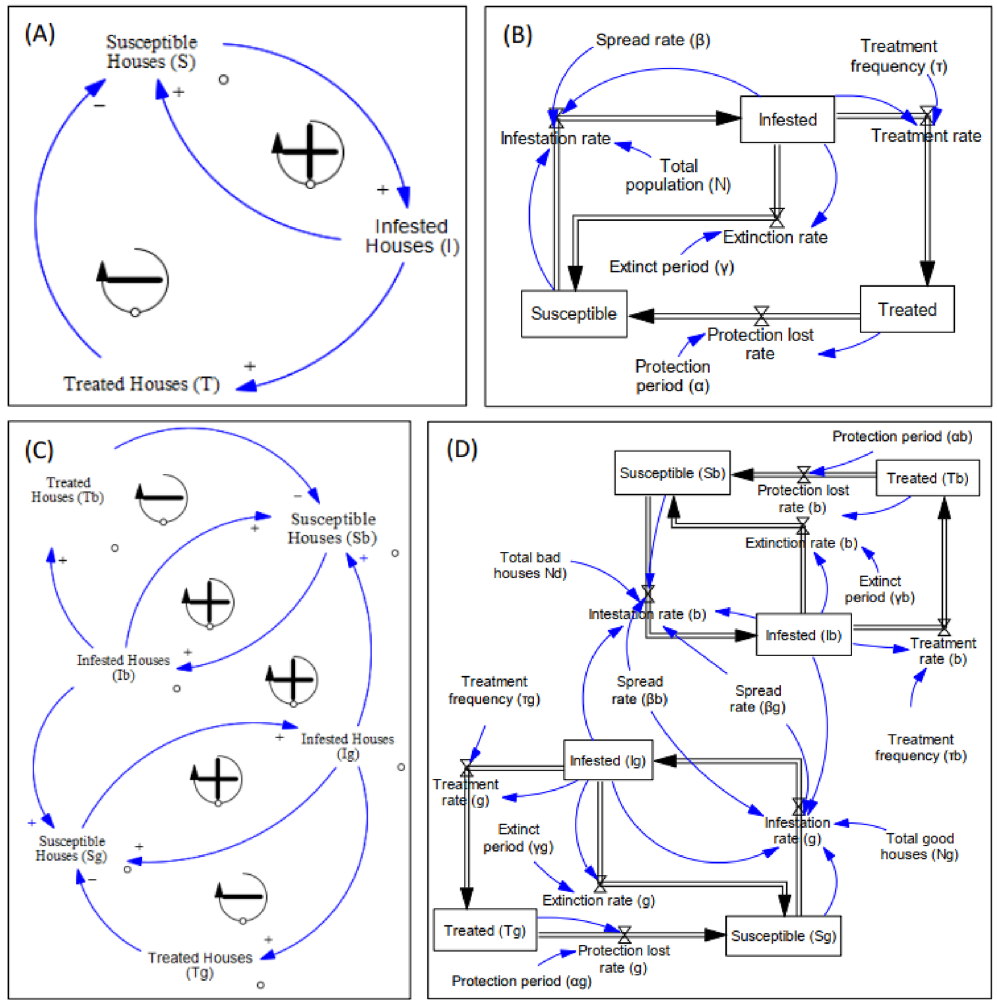
Figure 7. Susceptible-Infested-Treatment (SIT) model translated into causal loop diagram ( A ) and stock and flow diagram ( B ) for homogeneous houses and causal loop diagram ( C ) and stock and flow diagram ( D ) for heterogeneous houses in the